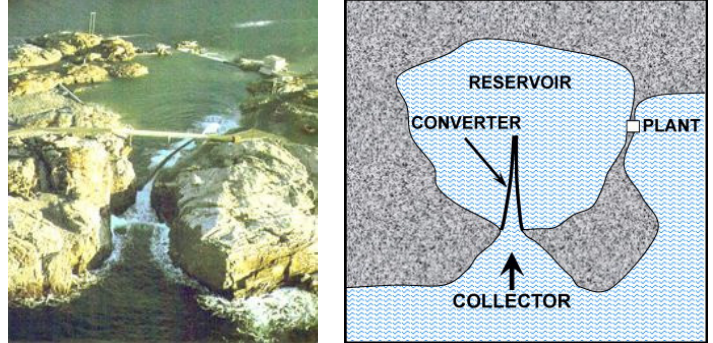
Historically, the first OD pilot plant was the Tapchan (Tapered Channel Wave Power Device), realized at Toftestallen (Norway) in 1985 (see Figure 29) [32,97]. The collector was carved into a rocky cliff, realizing an entrance about 60 m wide and lifting water into a reservoir 3 m above sea level and with a surface of 8500 m 2 . To convert the potential energy into electricity, a low-head Kaplan-type hydro turbine was adopted, with a rated power of 350 kW. This plant was damaged by the storm in 1988. The plant was decommissioned in 1991.